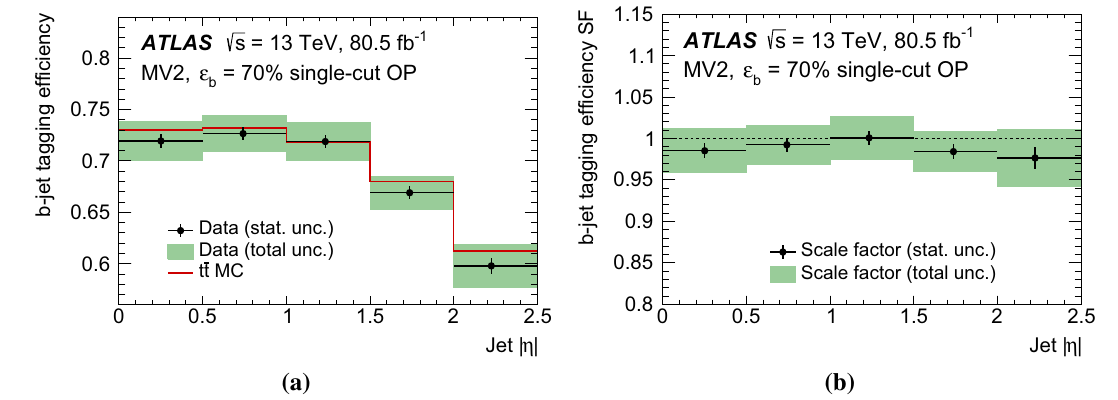
Fig. 10 The (a) b -jettaggingefficiencyand (b) b -jettaggingefficiency simulation-to-data scale factor for ε b = 70% single-cut OP of the MV2 tagger as a function of jet | η | . Vertical error bars include data statis-